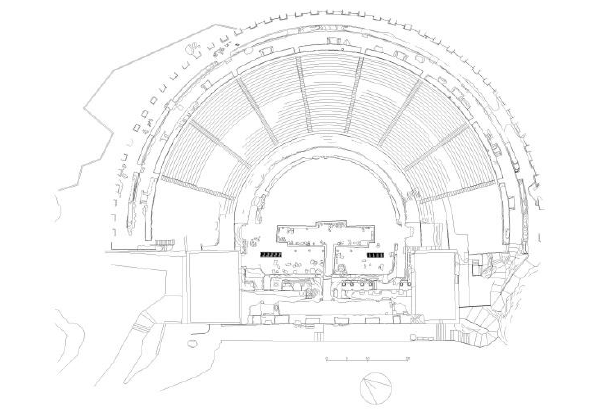
Figura 14 – Taormina theater, geometric interpretation starting from the